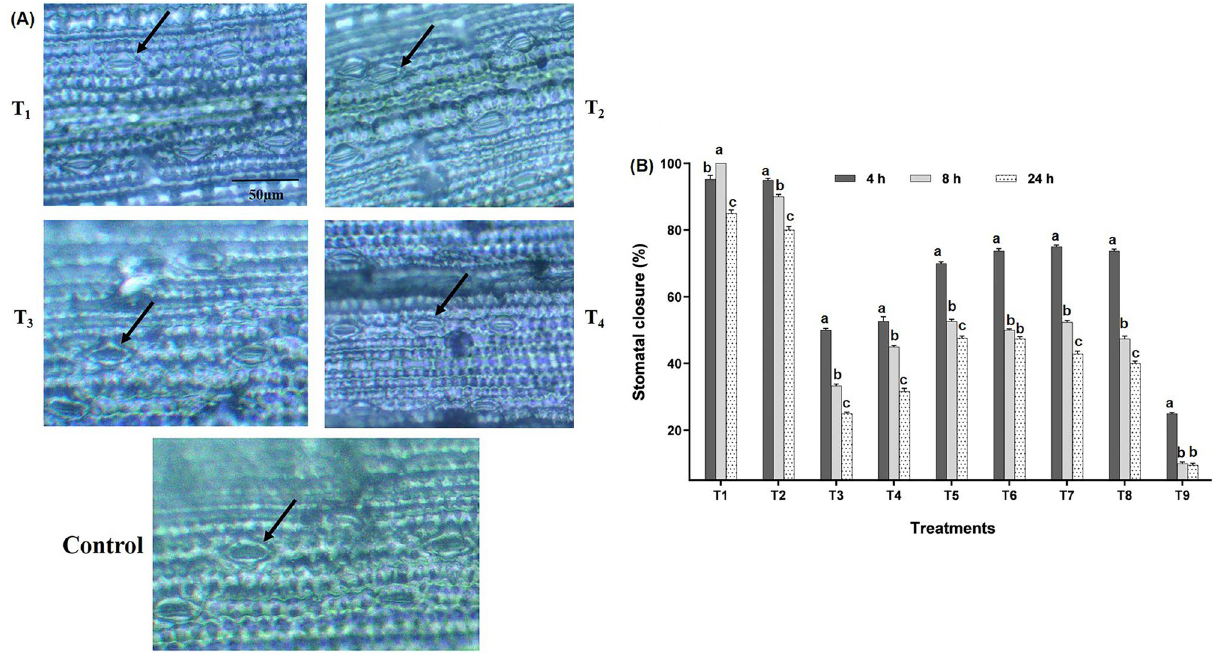
Figure 1. Effect of fungicidal stress on stomatal closure ( A ) stomatal response to different treatments at 4 h after the spray (T 1 : Tricyclazole, T 2 : Carbendazim, T 3 : LBS6 and T 4 : LBD1). ( B ) Bar graph showing the percent stomatal closure in different treatments across the intervals (Legends: T 1 : Tricyclazole, T 2 : Carbendazim, T 3 : LBS6, T 4 : LBD1, T 5 : Tricyclazole + LBS6, T 6 : Tricyclazole + LBD1, T 7 : Carbendazim + LBS6, T 8 : Carbendazim + LBD1, T 9 :